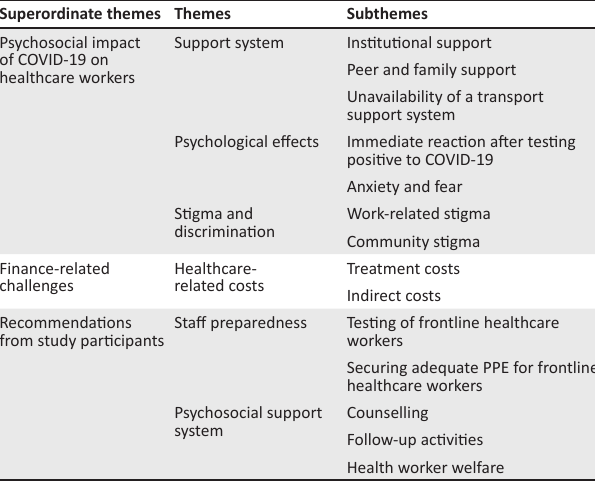
TABLE 2: Superordinate themes, themes and